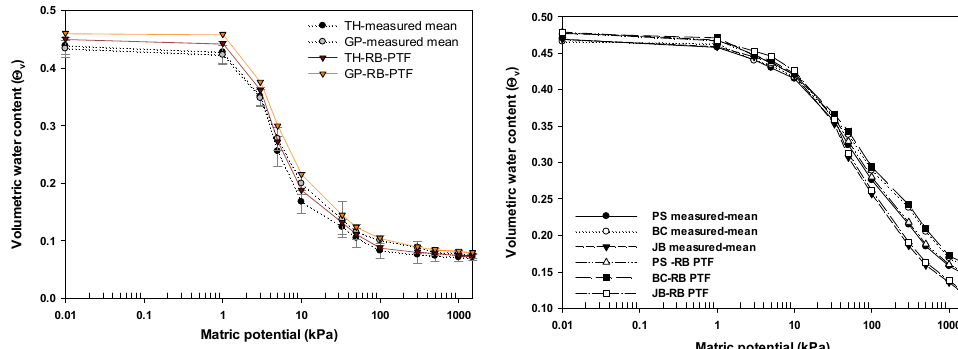
Figure 4. Measured and estimated SWRCs plotted using semi-logarithmic coordinates for matric potential from θ s to θ r for the five-soil series. The curves were obtained by drainage. TH, Taeahn series; GP, Gwangpo series; PS, Poseong series; BC, Bokchun series; JB, Junbook series. The RB-PTF SWRCs of sandy loam and silt loam were similar to those of the measured mean of sandy loam and silt loam, while the θ v obtained by RB-PTF were higher than those of the measured mean for sandy loam and silt loam. The differences of θ v between the